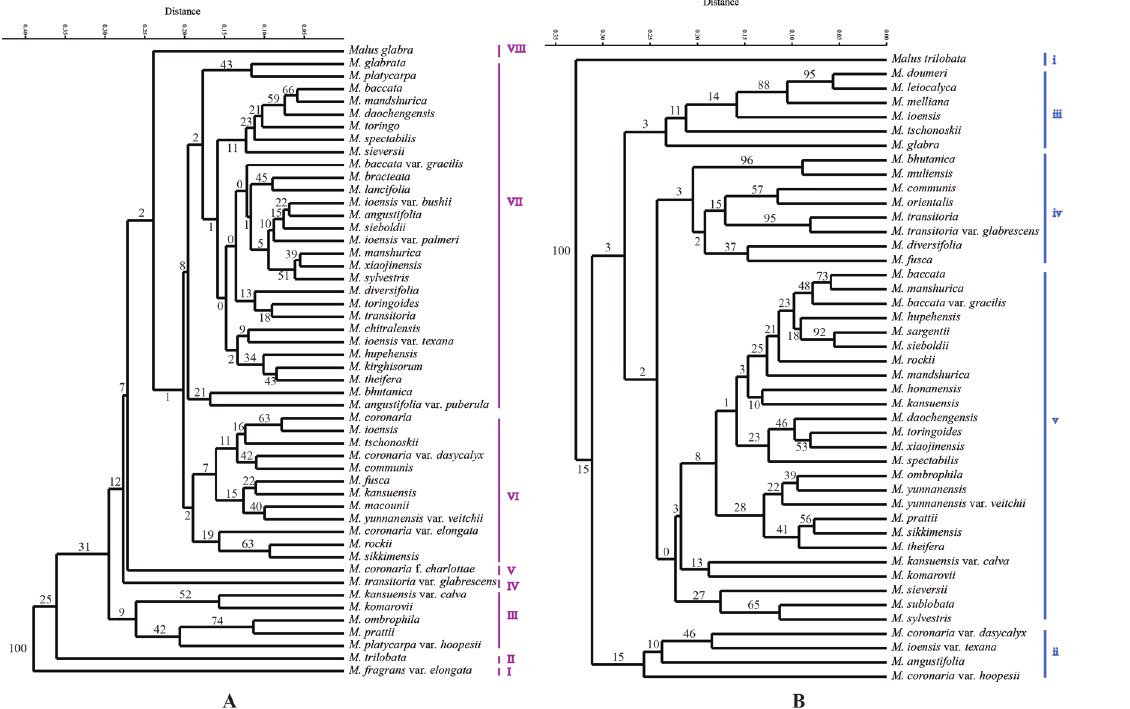
Fig. 2. Cluster analysis (UPGMA method of classification and Gower’s general similarity